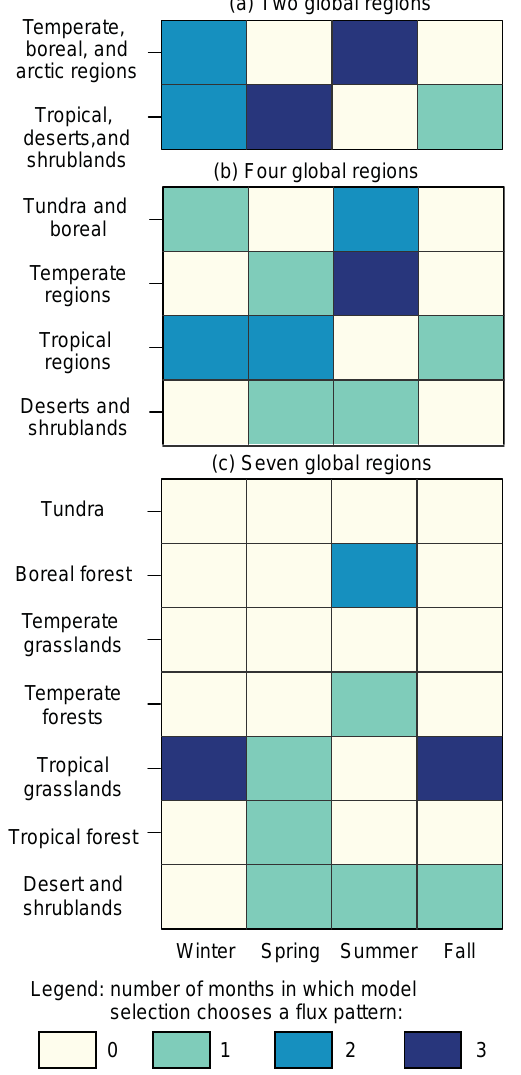
Figure 4. The results of the model selection experiments using real data. The different colors indicate the number of months in which at least one flux pattern is selected for a given region, and dark col- ors suggest excellent detectability while light colors suggest limited detection abilities. Flux patterns are selected for a greater fraction of regions and months in the two-region case (a) than in the four- or seven-region cases (b–c)